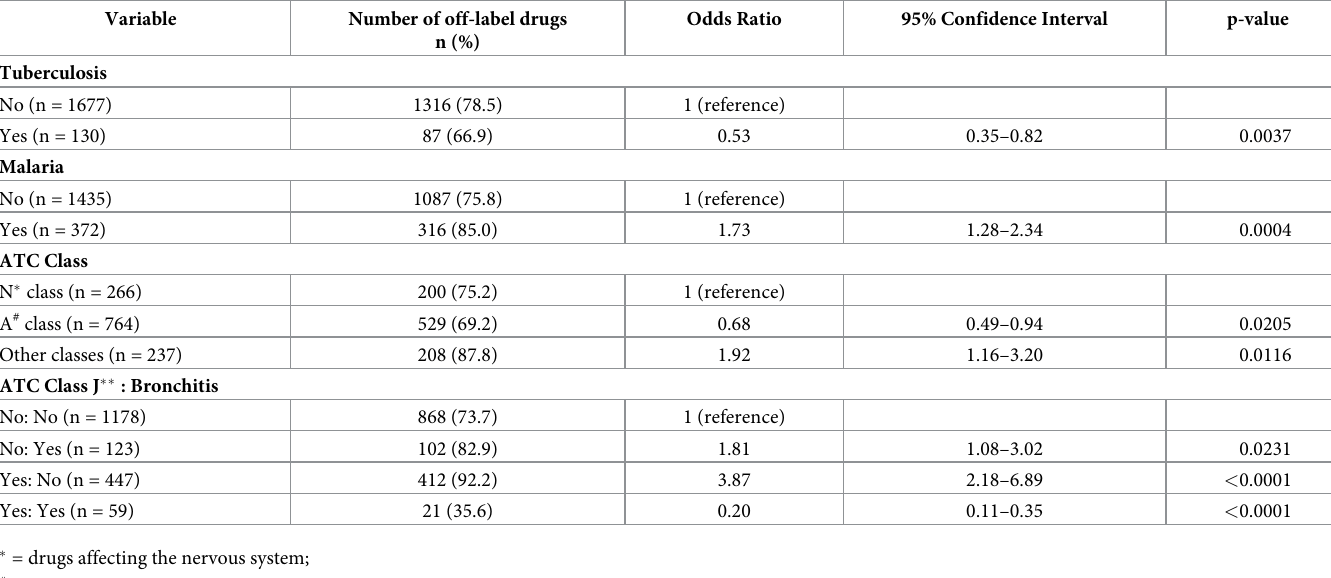
Table 5. Analysis of association with a drug being defined as off-label using a Generalized Estimating Equation (GEE). (n = 1807 licensed drugs prescribed on or off- label). The “n” in the first column shows the total number of drugs prescribed, while the “n” in the second column shows the number which were off-label.